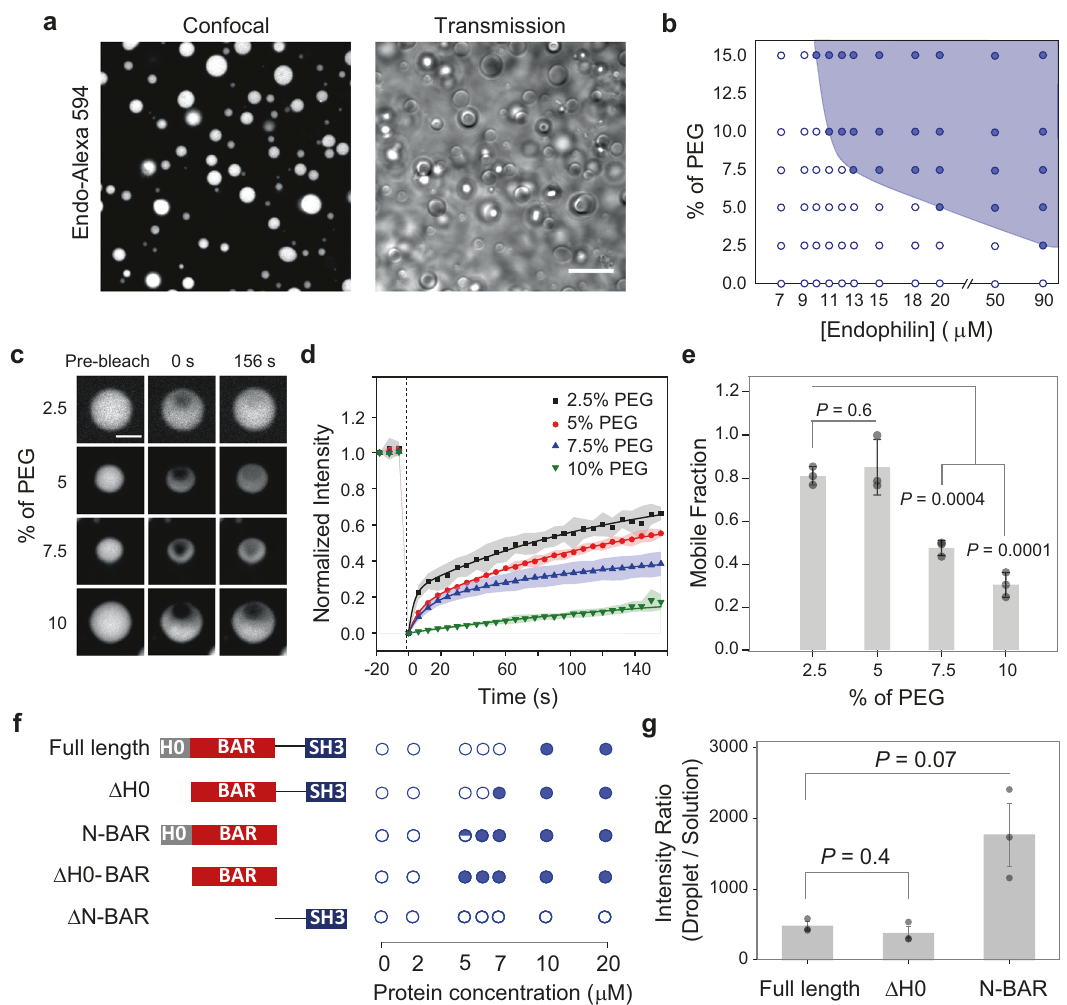
Fig. 1 | Endophilin undergoes LLPS in a crowded environment. a Droplets formed by rat endophilin A1 (25 µ M) in the presence of 10% PEG. Left, confocal fl uorescence image of LLPS droplets of endophilin doped with Alexa 594-labeled endophilin (1 µ M); right, transmission image of the droplets. Scale bar 10 µ m. b Phase diagram showing endophilin-PEG LLPS system. The fi lled circles indicate where liquid-like droplets were observed, whereas the open circles indicate no droplet formation. c Representative confocal images of endophilin droplets before, 0s after, and 156s after photobleaching at different PEG concentrations. Unlabeled endophilin concentrations used for droplet formation were 150, 50, 25, and 25 µ M for 2.5, 5, 7.5, and 10% PEG, respectively, and Alexa 488-labeled endo- philin (1 µ M) was used for fl uorescence imaging. Scale bar 2 µ m. d FRAP time pro fi les to show the recovery rate at different PEG concentrations. Normalized intensities of the bleached area relative to the unbleached intensities are plotted for each time point. Each data point is an average of three repeats performed on different droplets, error bars indicate standard deviation. The solid lines indicate